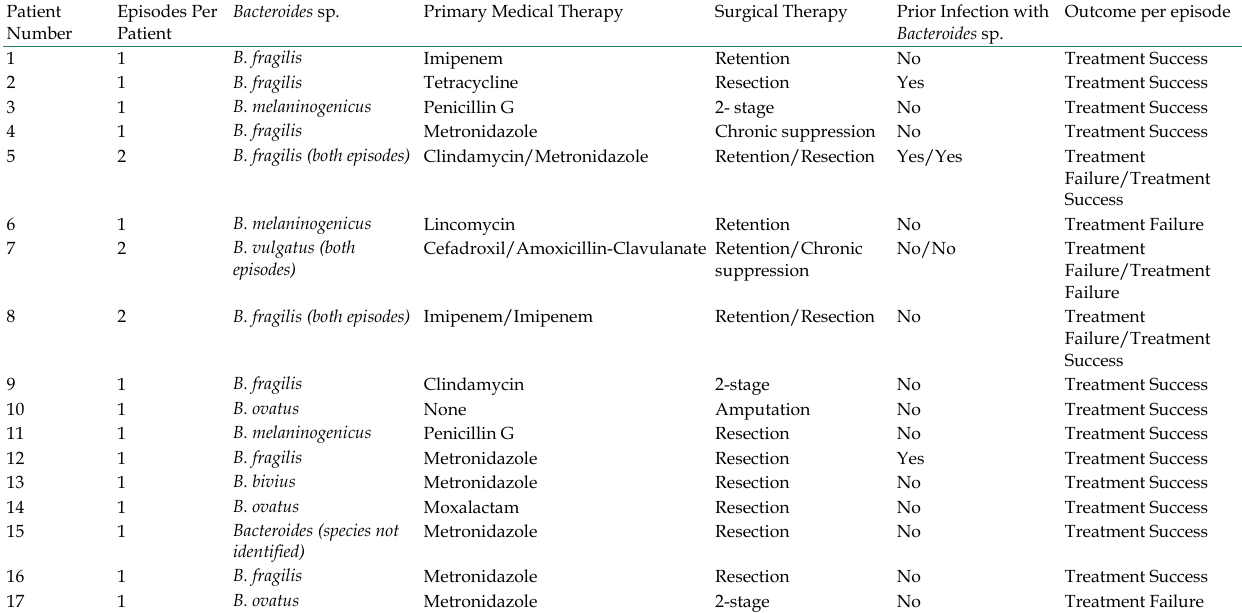
Table 1 . 17 Patients with Bacteroides PJI, classified by species isolated, medical and surgical therapy and prior exposure Patient Number